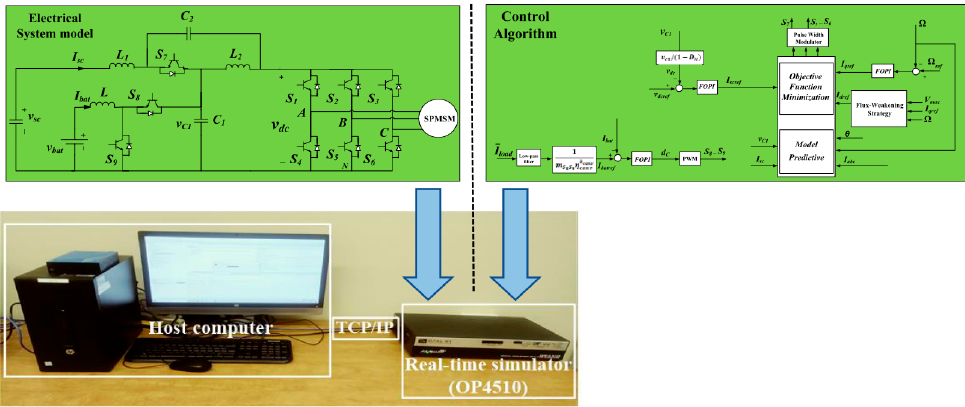
Figure 4. e-TESC 4W platform (adapted from BRP e-Commander vehicle).